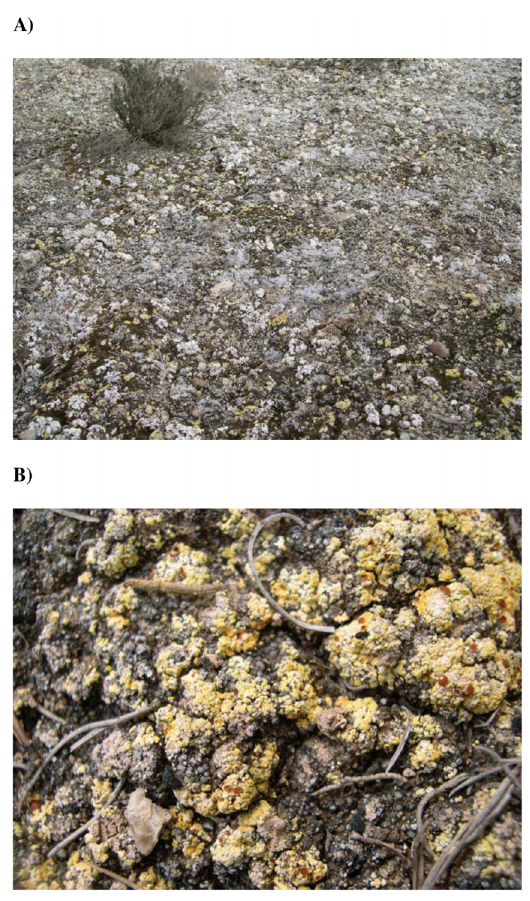
between plants in non-disturbed gypsum outcrops from central thalli) and Toninia sedifolia (grey and black